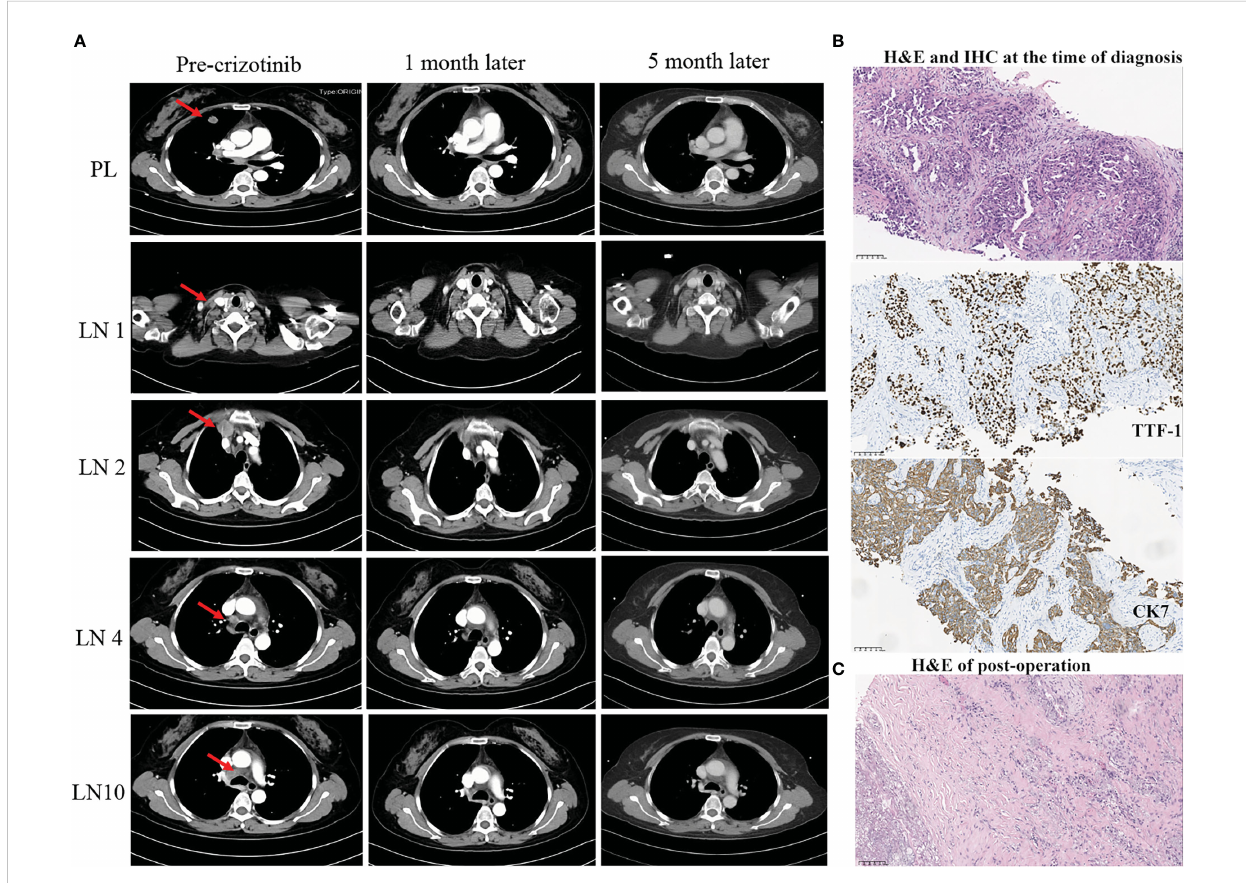
FIGURE 1 Summary of radiology, pathology, and next-generation sequencing (NGS) results (A – C) . (A) Radiological evaluation of the patient before and after neoadjuvant crizotinib for 1 and 5 months. PL, primary lung cancer; LN, lymph nodes. (B) H&E and IHC staining. The result demonstrated at the time of diagnosis of NSCLC (scale bar, 100 m m). (C) H&E staining post-operation. The result showed no residual viable cancer cells after adjuvant crizotinib treatment (scale bar, 100 m m). H&E, hematoxylin and eosin; IHC,